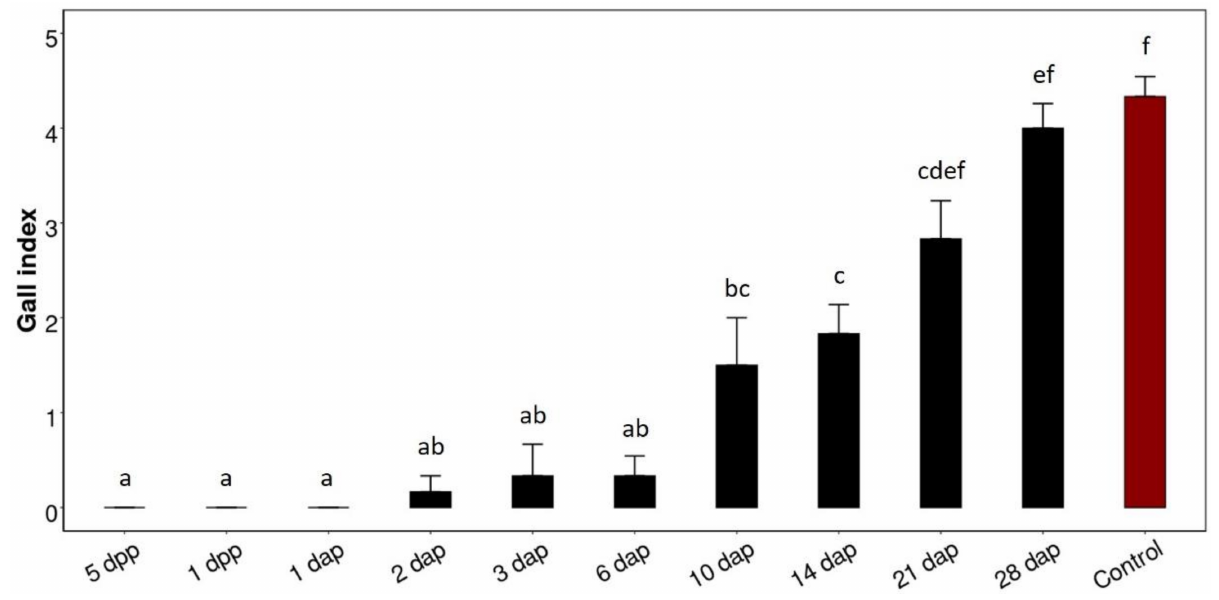
Figure 2. Root-gall rating of tomato roots grown in Meloidogyne incognita second-stage juvenile infected soil, treated with fluopyram at different time points. Pots were inoculated with 5000 J2s/pot and treated with fluopyram 5 days or 1 day pre-planting (dpp) or 1, 2, 3, 6, 10, 14, 21 or 28 days after planting (dap). The gall index was recorded according to Zeck’s scale of root-knot infection [19] (n = 6). Different letters indicate significant differences compared to the control according to a one-way ANOVA with post-hoc Tukey HSD test ( p ≤ 0.05).